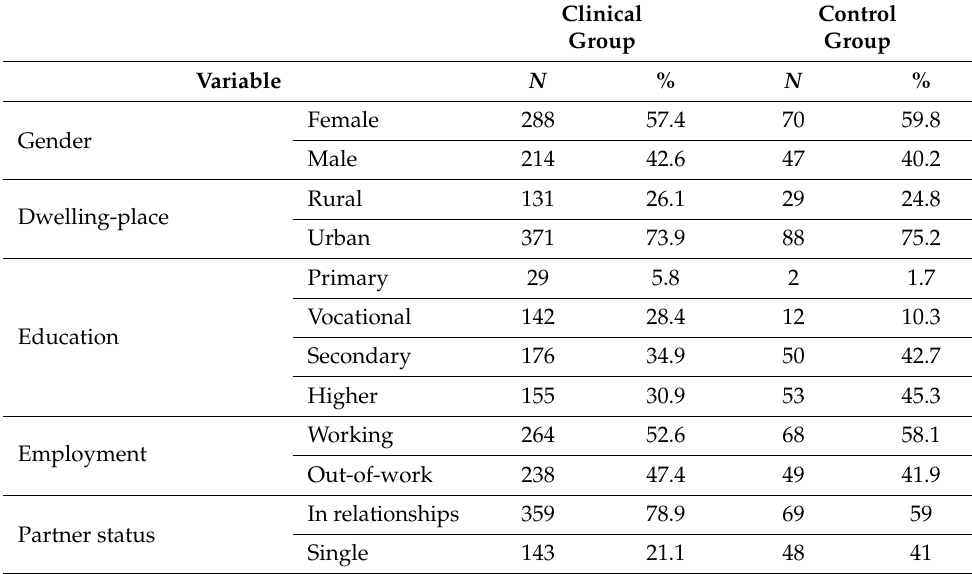
Table 1. Sociodemographic characteristics of the